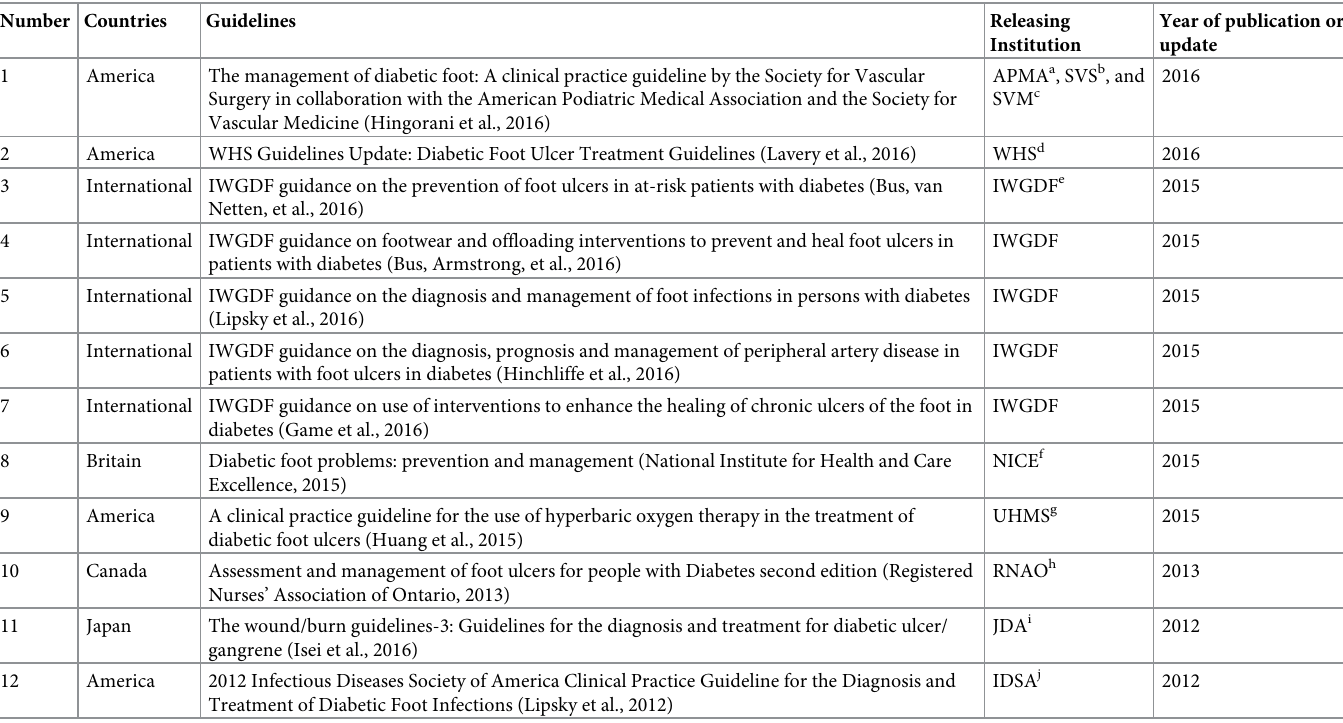
Table 1. General information regarding the